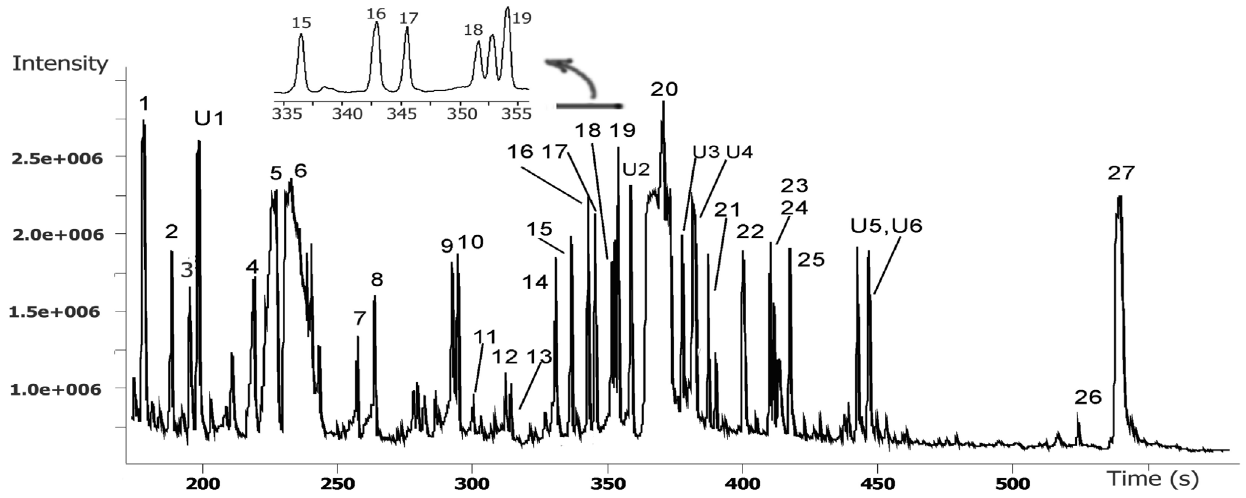
Figure 1. A typical GC/TOFMS chromatogram of blood plasma. Several hundreds of peaks can be detected at only one analysis and some of the peaks were identified. Part of the chromatogram was zoomed in for clear inspection of the peaks, 15–19, retention time from 335 to 355 s. 1, Lactate; 2, butyamine; 3, 3-hydroxybutyrate; 4, valine; 5, urea; 6, phosphate; 7, serine; 8, threonine; 9, pyroglutamate; 10, hydroxyproline; 11, creatinine; 12, ornithine; 13, phenylalanine; 14, methyl myristate (QC reference standard); 15, glutamine; 16, glycerol-3-phosphate; 17, azelate; 18, citrate; 19, [ 13 C 2 ]-myristic acid (stable isotope internal standard); 20, glucose; 21, palmitic acid; 22, uric acid; 23, linoleic acid; 24, oleic acid; 25, stearic acid; 26, alpha-tocopherol; 27, cholesterol; U1-5, unidentified peaks of retention indices at 1163, 1876, 1986, 2015, 2415, 2448, respectively.